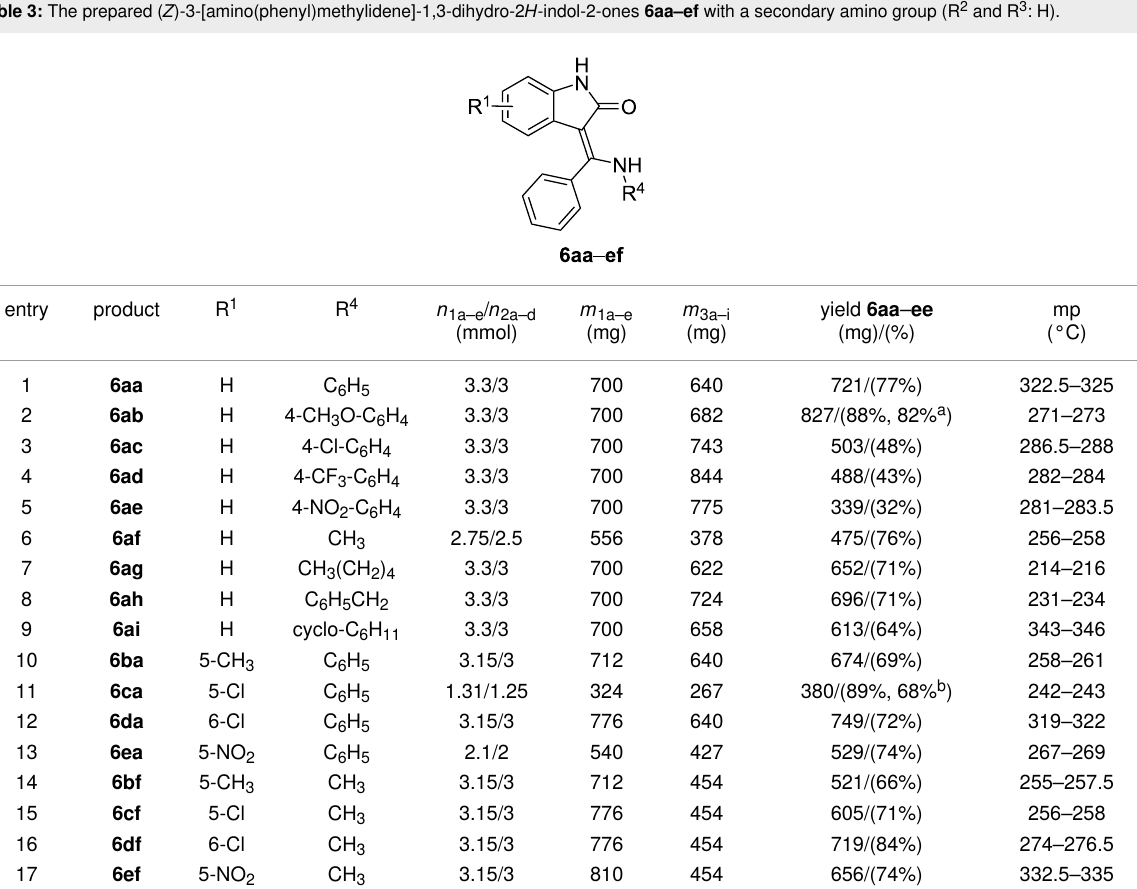
Table 3: The prepared ( Z )-3-[amino(phenyl)methylidene]-1,3-dihydro-2 H -indol-2-ones 6aa–ef with a secondary amino group (R 2 and R 3 :